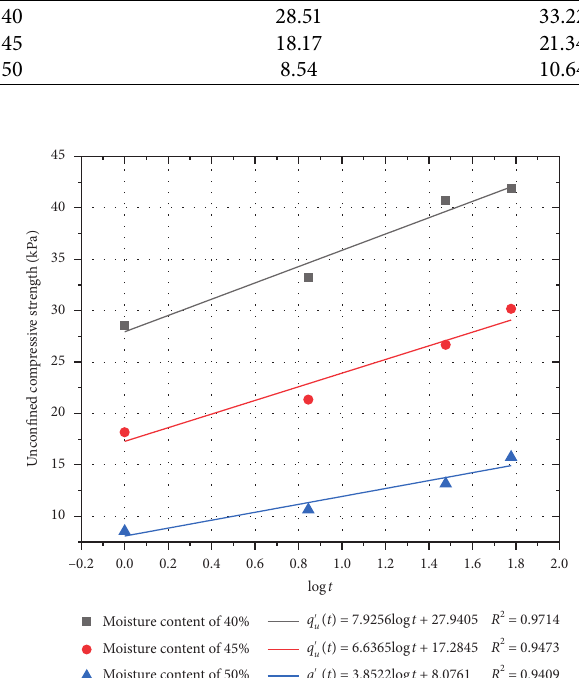
( t ) − log t of samples with different u ′